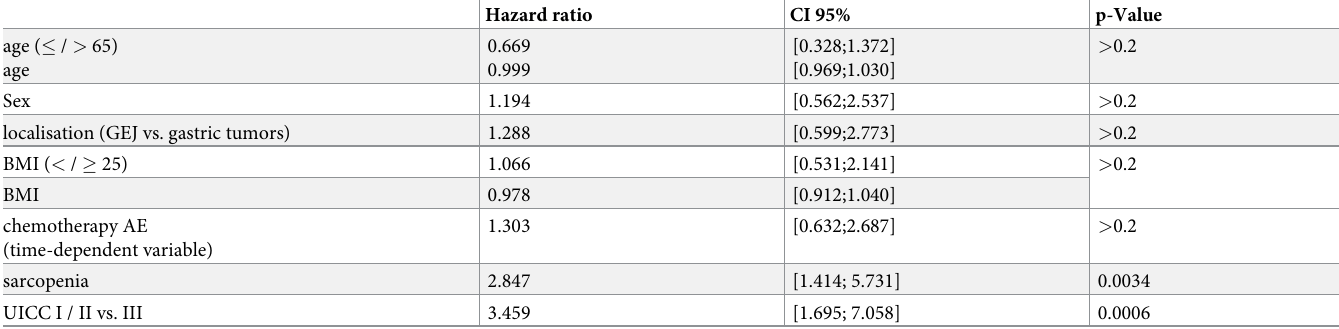
Table 5. Risk factors for survival; univariate Cox regression